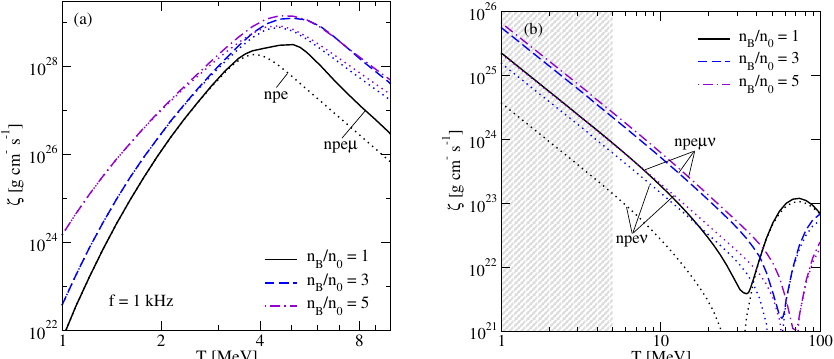
Figure 8. The bulk viscosity of relativistic npe µ matter as a function of the temperature for ( a ) neutrino-transparent matter at f = 1 kHz; ( b ) neutrino-trapped matter. The region T ≤ 5 MeV in panel ( b ) is shaded because neutrinos are no longer trapped at those temperatures. The dotted lines show the bulk viscosities of relativistic npe